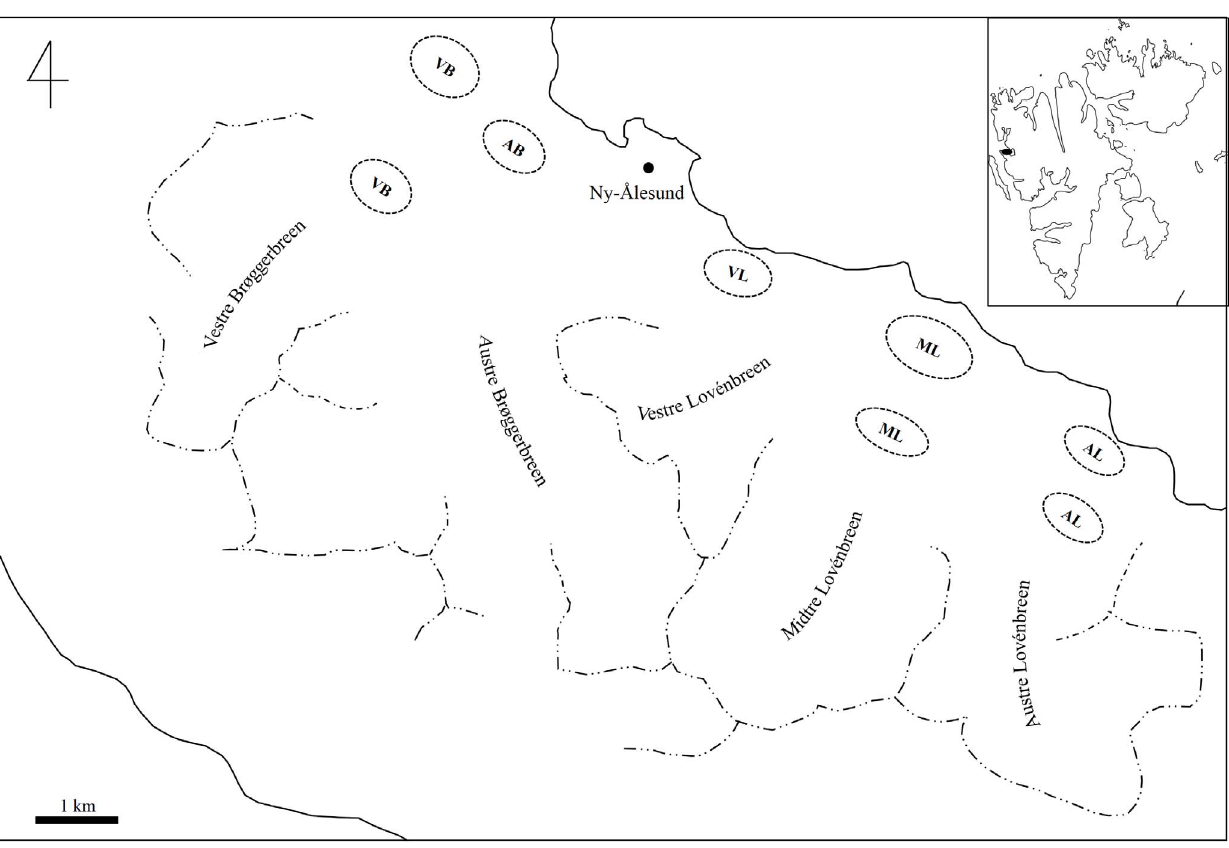
Figure 1. The study area, Ny-A˚lesund (78 6 53’-78 6 55’N, 11 6 46’-12 6 11’E), northwest coast of Spitsbergen Island, Svalbard in Norway. Eight different sites were selected as sampling sites around two different glaciers. First letter of abbreviation represented directions: A: east (Austre), M: middle (Midtre), V: west (Vestre). Last letter of abbreviation represented two different glaciers: B: Brøggerbreen, L: Love´nbreen.